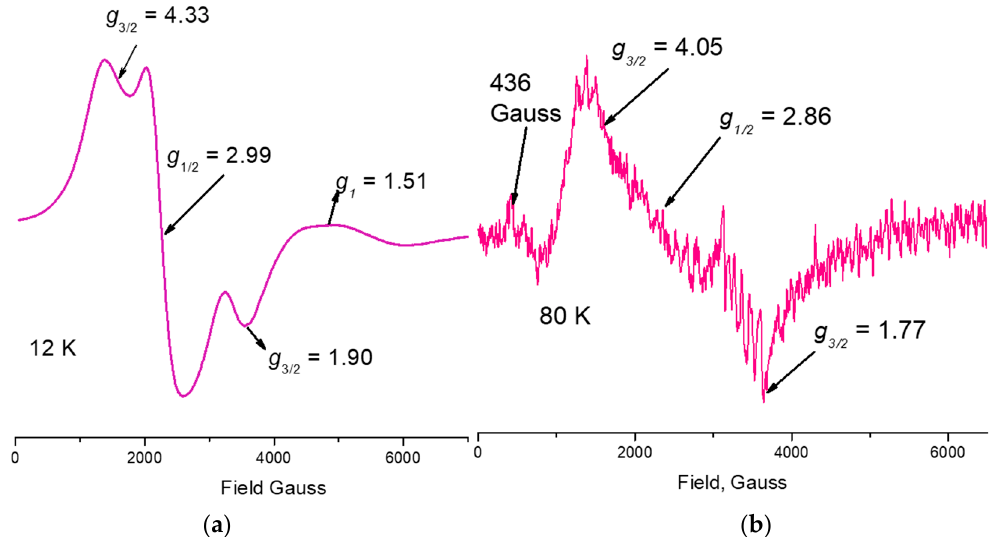
Figure 6. ESR spectra of 1 . ( a ) Powder sample at 12 K showing the resolution of the transitions bands of the different Mn ions oxidation states; ( b ) Solution sample at 80 K showing the unpaired electrons with the 55 Mn nucleus, I 5/2 , hyperfine interaction showing at least two groups of signals with values of its coupling constants of 89 G and 94 G values.